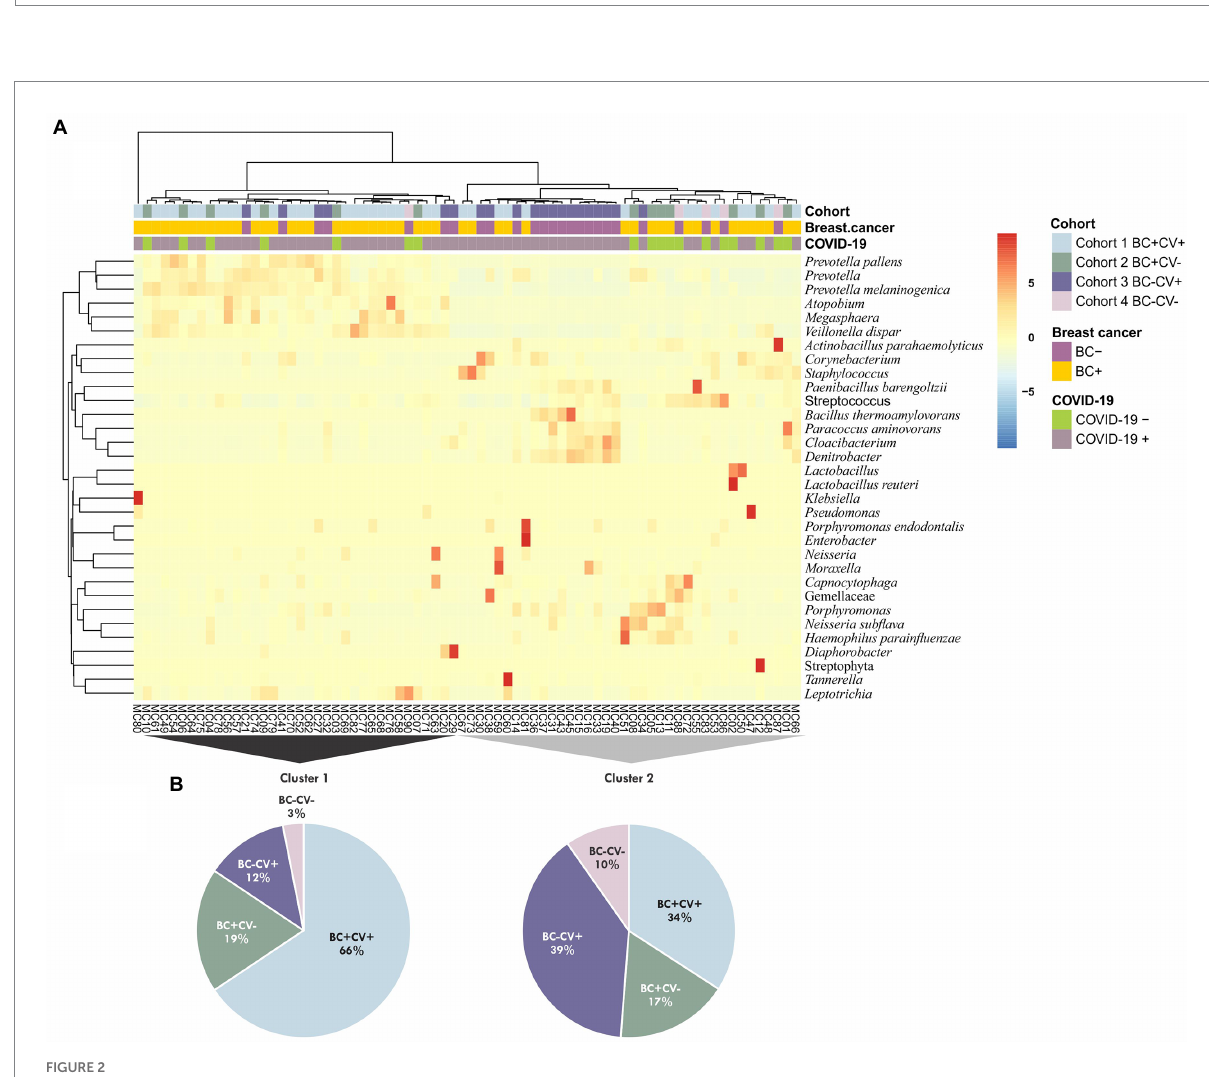
FIGURE 2 (A) Cluster analysis considering all taxa identified in the four groups of samples (CV + BC+, CV-BC+, CV + BC-, and CV-BC-). The analysis was performed using unsupervised hierarchical inferences based on Bray–Curtis dissimilarity and average linkage considering the abundance and taxa diversity of each sample; the heatmap shows the taxa with relative abundance ≥ 1%. (B) Pie charts showing the contribution of the different groups of samples for the two major clusters (Cluster 1 and Cluster 2), colors are respective to each cohort as presented in A